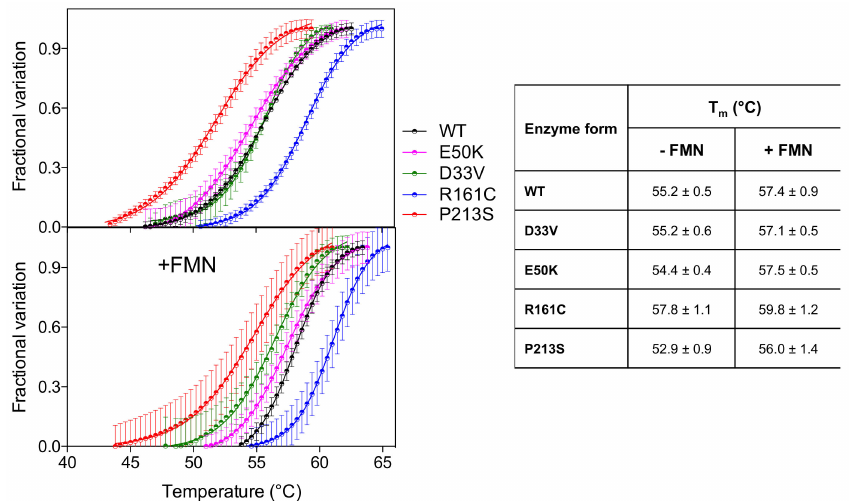
Figure 2. Temperature dependence of fluorescence change is expressed as fractional variation for the wild type PNPO and all variants (2 µ M) indicated in the legend. The purified variants are tested without and with an equimolar amount of FMN (+FMN). The curves shown in the figure are the average with standard error bars of three independent experiments. Data are fitted to the Boltzmann equation to obtain the melting temperatures (listed in the table on the